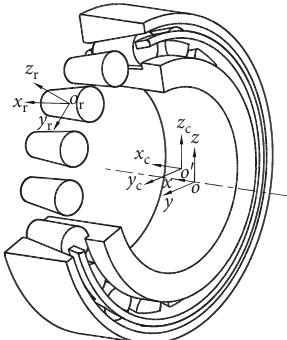
Figure 1: Bearing coordinate system.